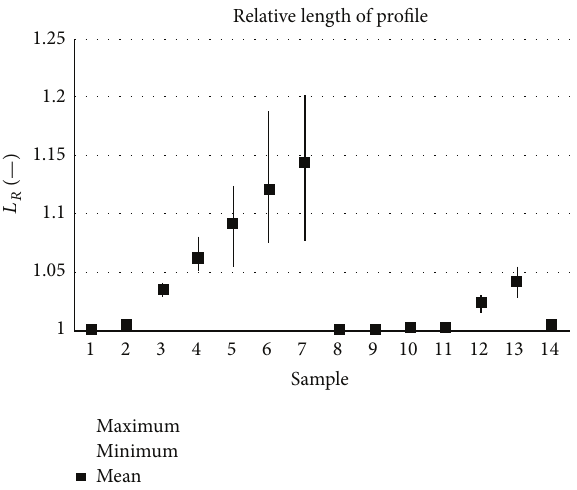
Figure 12: Results of relative length measurement, 𝐿 𝑅 ( 𝑥 -axis).